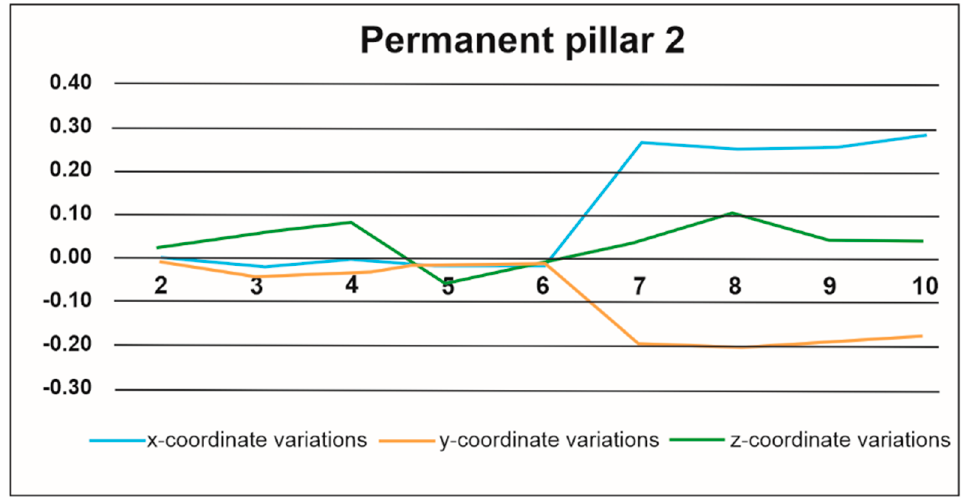
Figure 15. Variation of the coordinates of permanent pillar 2 over time. The x -axis corresponds to the period of GNSS measurements, while y -axis displays the observed displacements.